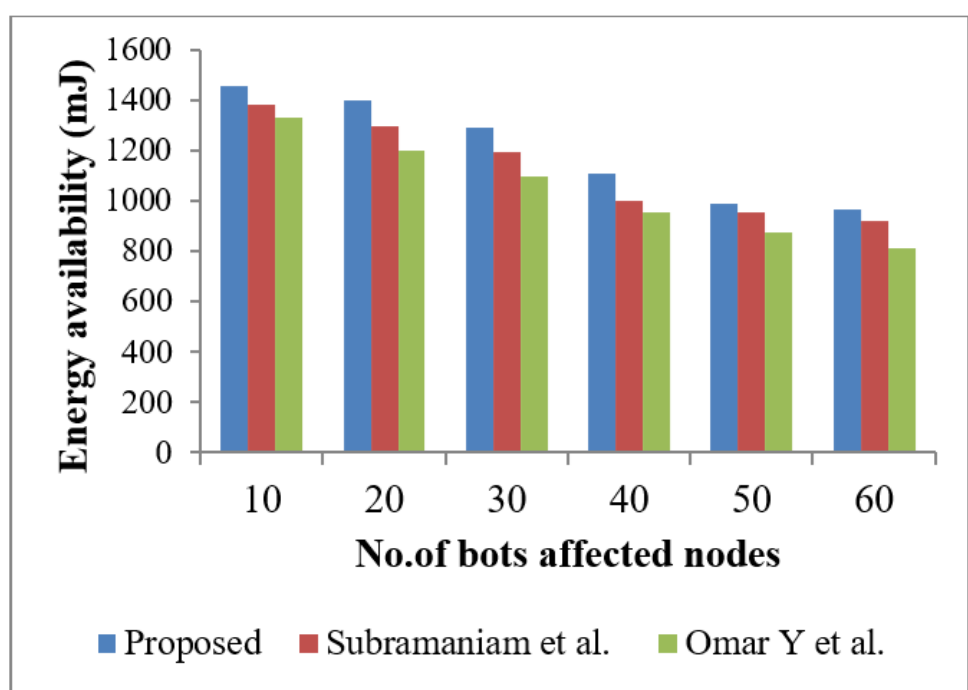
Figure 8. Comparisons of Energy availability.